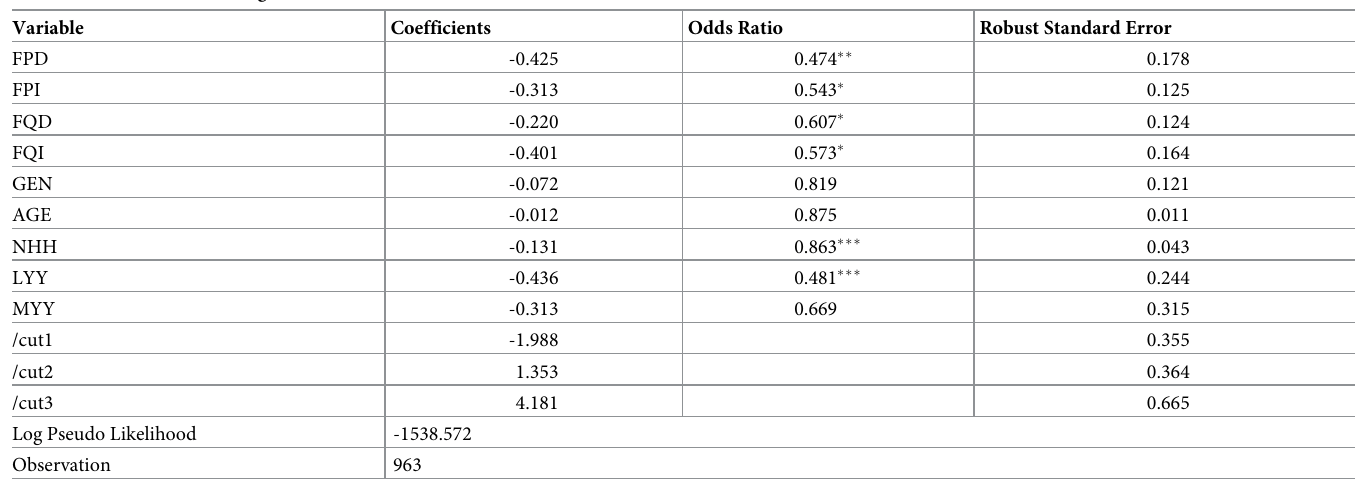
Table 4. Results of ordered logit